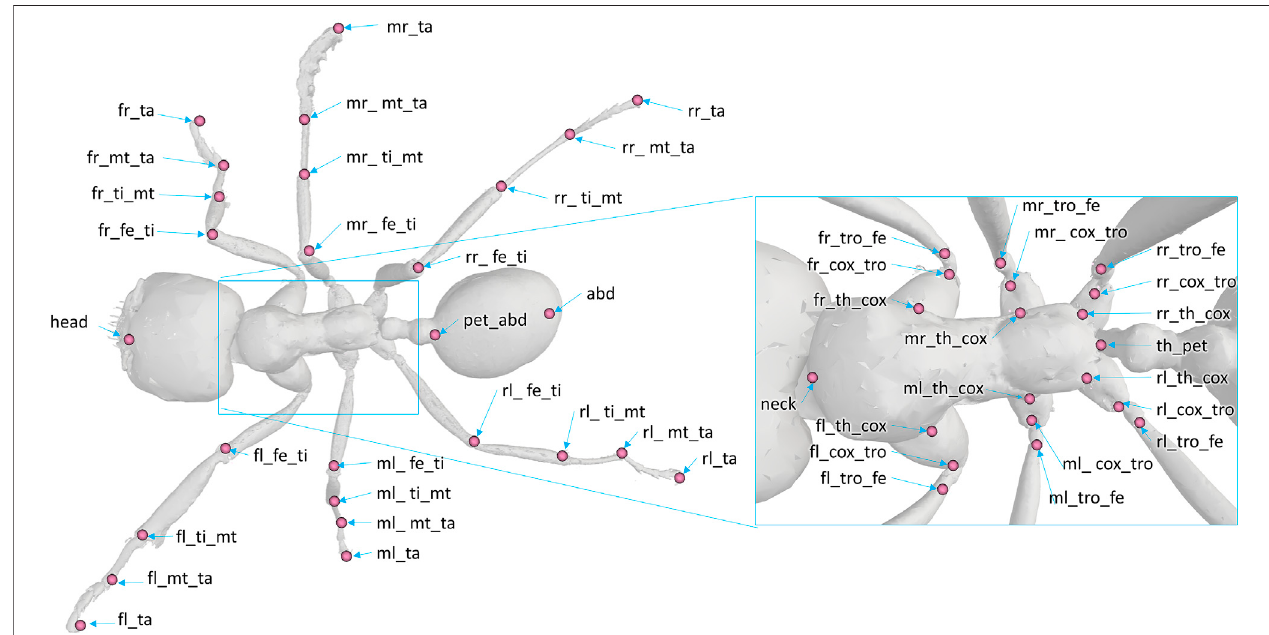
FIGURE 4 | Position and denomination of the markers on the model. The following abbreviations are used for the denomination of the markers. Pre fi x: f (front), m (middle), or r (rear); position: l (left), r (right). Anatomy and articulation: th (thorax), pet (petiole), abd (abdomen), cox (coxa), tro (trochanter), fe (femur), ti (tibia), mt (metatarsus), ta (tarsus).